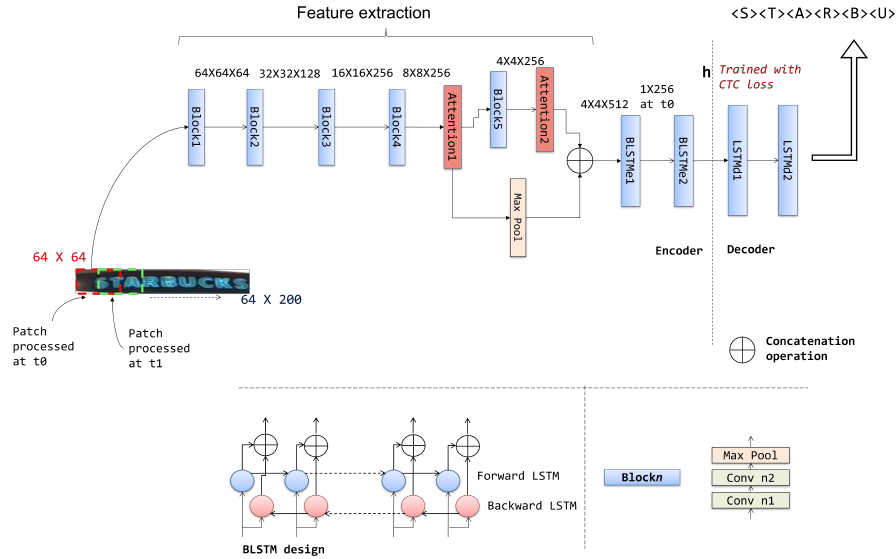
Figure 1. Convolutional recurrent neural architecture for scene text analysis: the bidirectional LSTM, and the convolutional block structure are given below. The dimension of intermediate feature maps is given above the